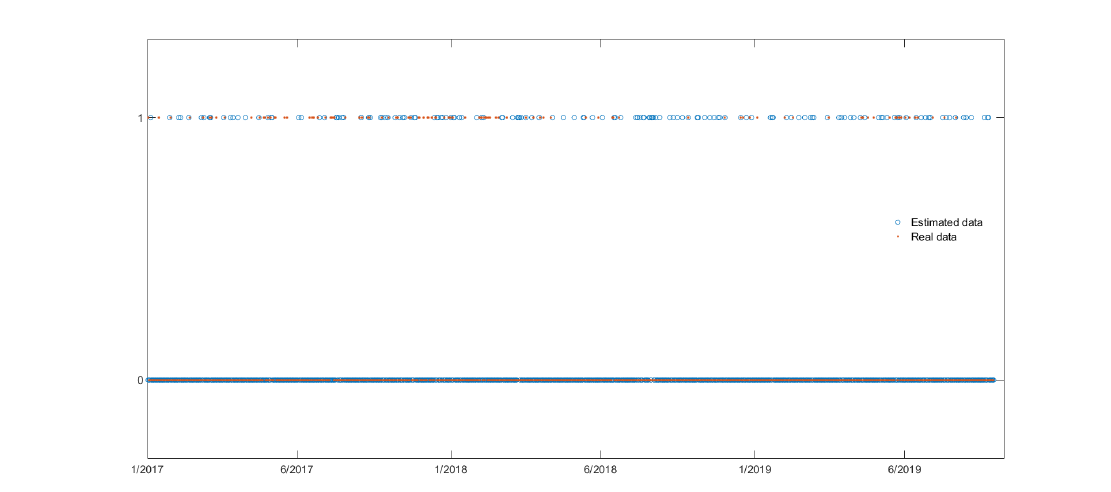
Figure 1. Realization of the binary BTC series with α = 5% using the logistic regression model. The blue circles represent the realized series whereas the red dots are the actual data